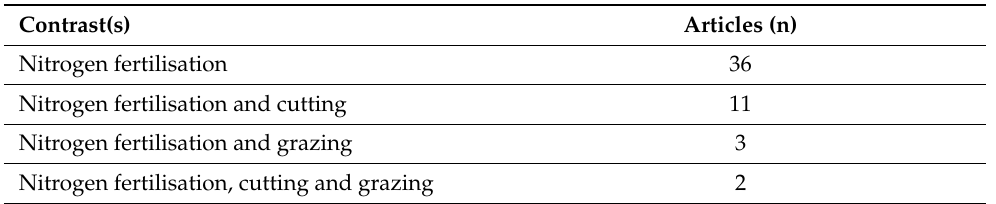
Table A2. Summary of co-author ratings of strength of evidence components.